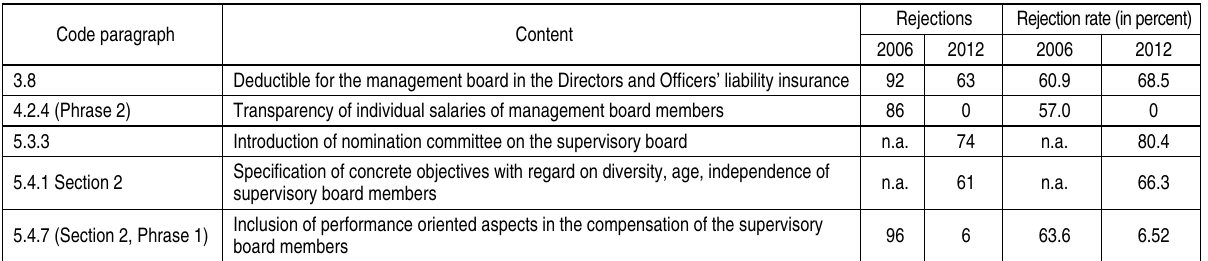
Table 3. Five most critical recommendations of SME code